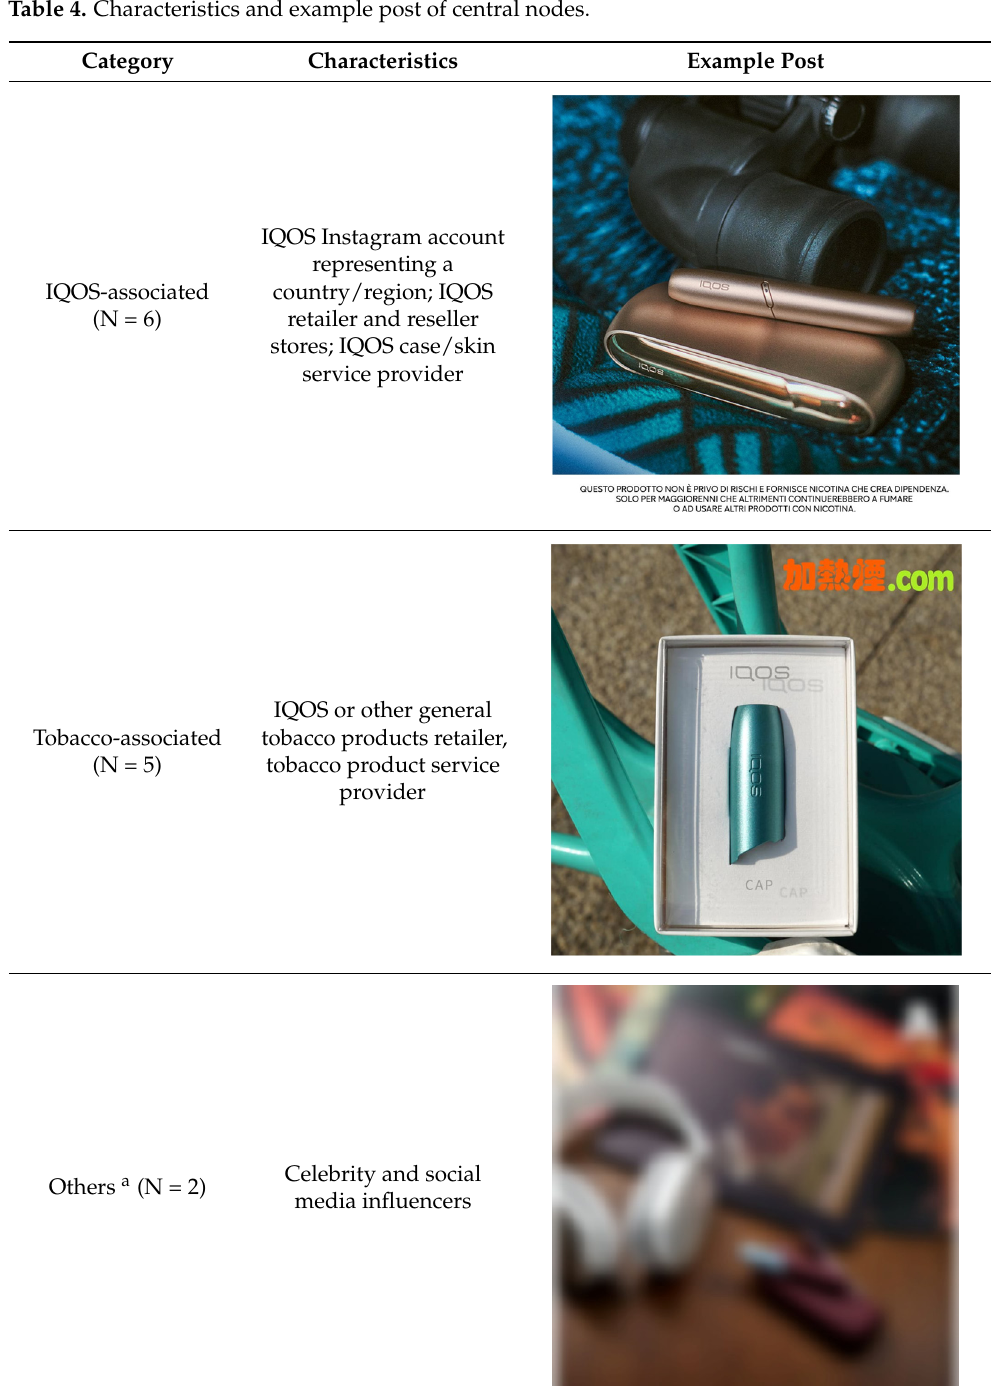
Table 4. Characteristics and example post of central nodes.